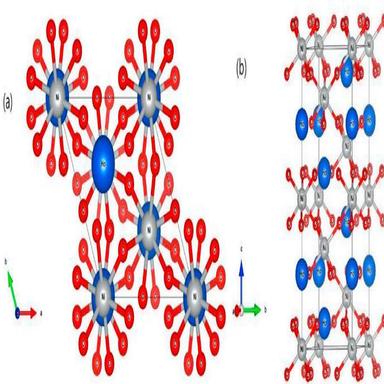
Crystal structure of rhombohedral R3c-type HoNiO3.